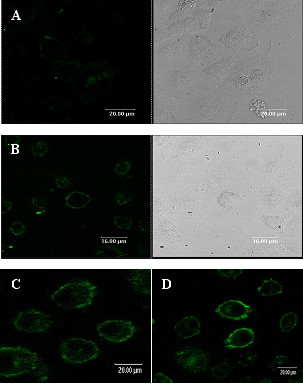
Confocal assay for the expression of FasL on the membrane of co-cultured Bel 7402 cells. Bel 7402 cells and Jurkat T cells were co-cultured with AFP (20 mg/L) for 48 h. After removing Jurkat cells, Bel 7402 cells were incubated with rabbit anti-FasL antibody and secondary goat anti-rabbit IgG antibodies conjugated with FITC. The cells were observed using a confocal laser scanning microscope. Image A: separate-cultured Bel 7402 cell; B: separate-cultured Bel 7402 cells treated with AFP. Right images of A and B were taken under common microscope to observe the state of cells. C: co-cultured Bel 7402 cells without AFP treatment; D: co-cultured Bel 7402 cells treated with AFP. All images were representative of an experiment that was repeated three times.